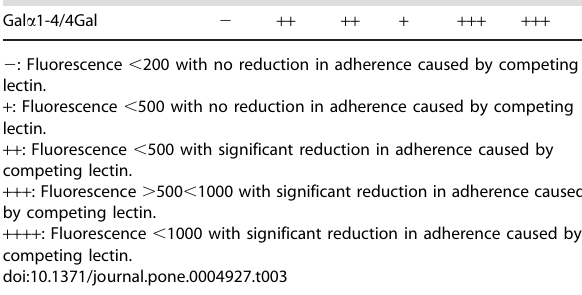
Figure 6. Lectin inhibition of C.jejuni adherence to intestinal cell line. C. jejuni 11168-GS (A) and 11168-O (B) adherence to Caco-2 cells pre-treated with ECA, UEA-1, ConA, LFA, MAA and SNA (25 u C, black bar; 37 u C, grey bar; and 42 u C, white bar). * Significant difference to non- lectin treated control, P , 0.05; ND, Not determined.